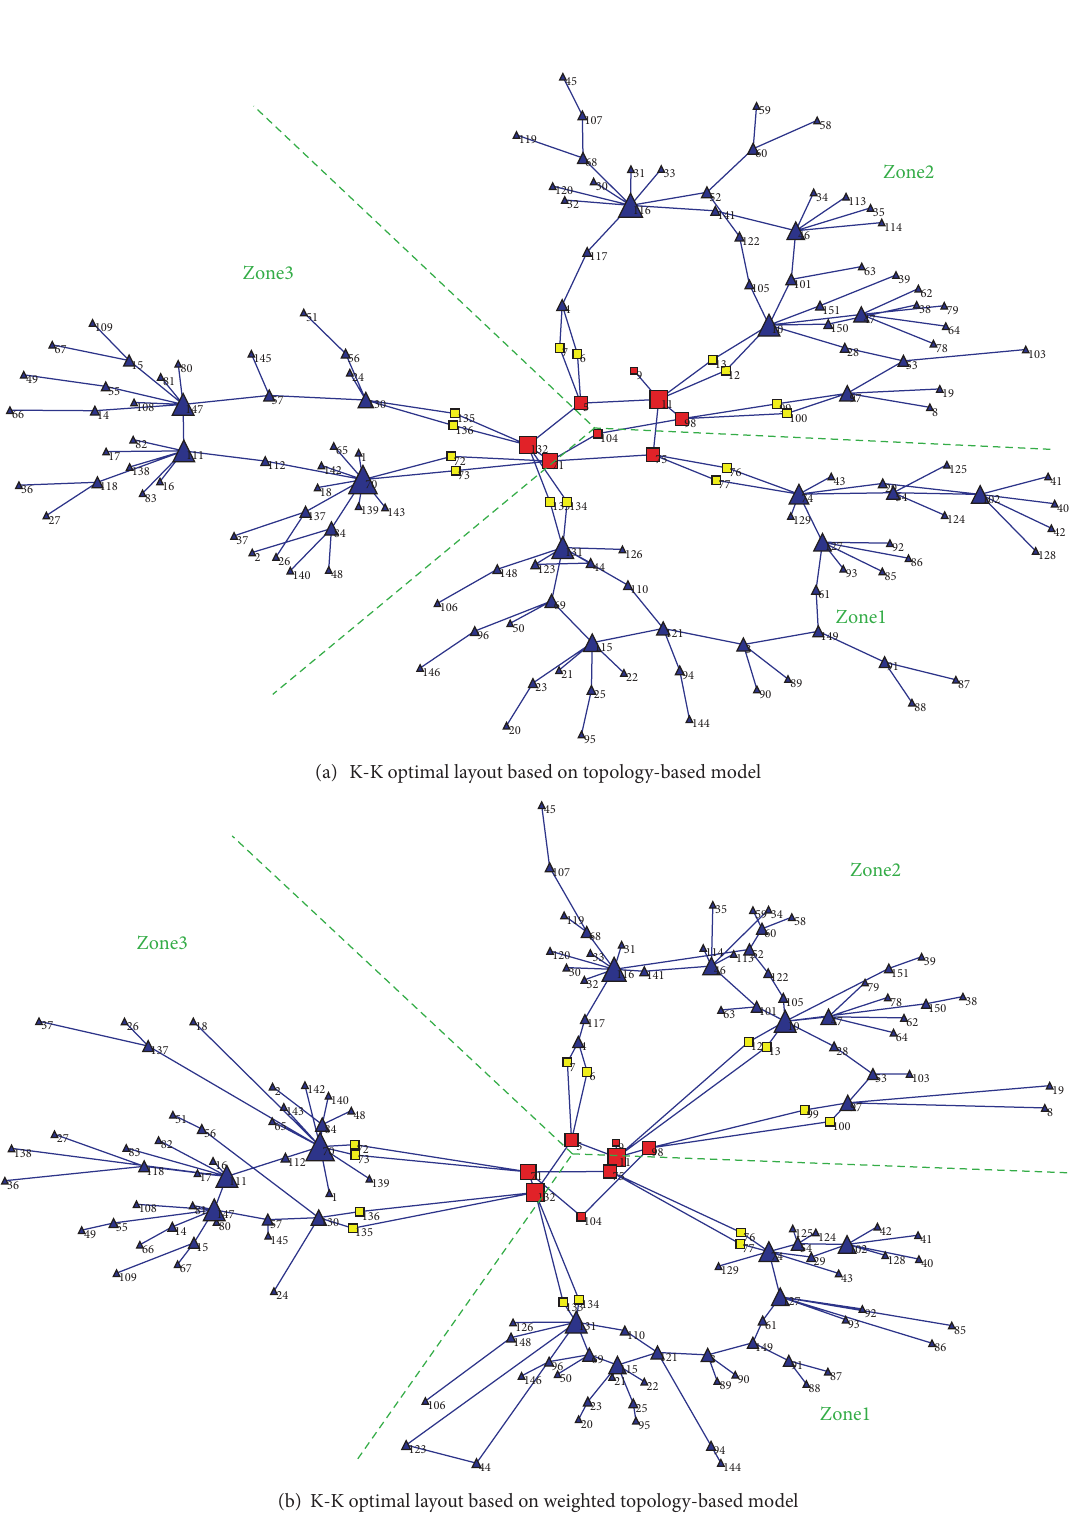
(b) K-K optimal layout based on weighted topology-based model Figure 4: Optimal layout of TJ220